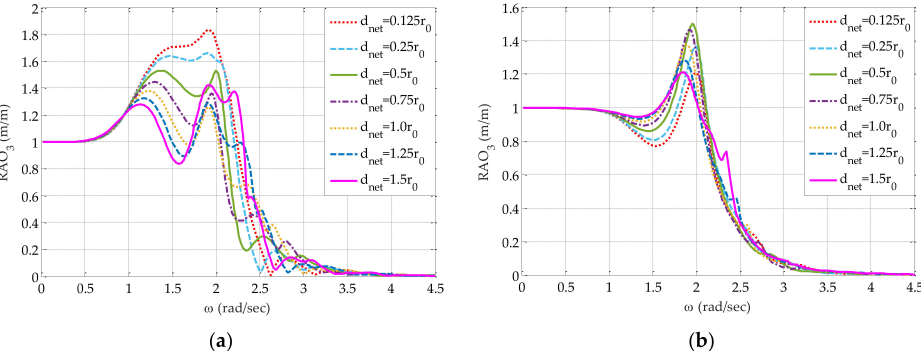
Figure 11. Effect of d net on the heave response of the hemispherical-shaped WECs placed around the monopile for β = 0 o : ( a ) WEC1 and WEC4; ( b ) WEC2 and WEC3.